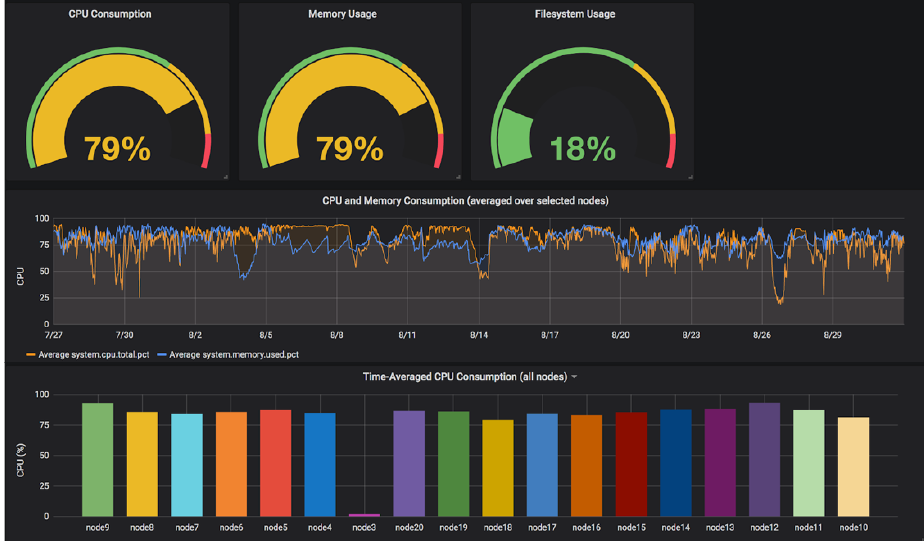
Fig. 1. Prometheus monitoring showing resource usage for one of the Kubernetes clusters 3 Central perspective: integration with the